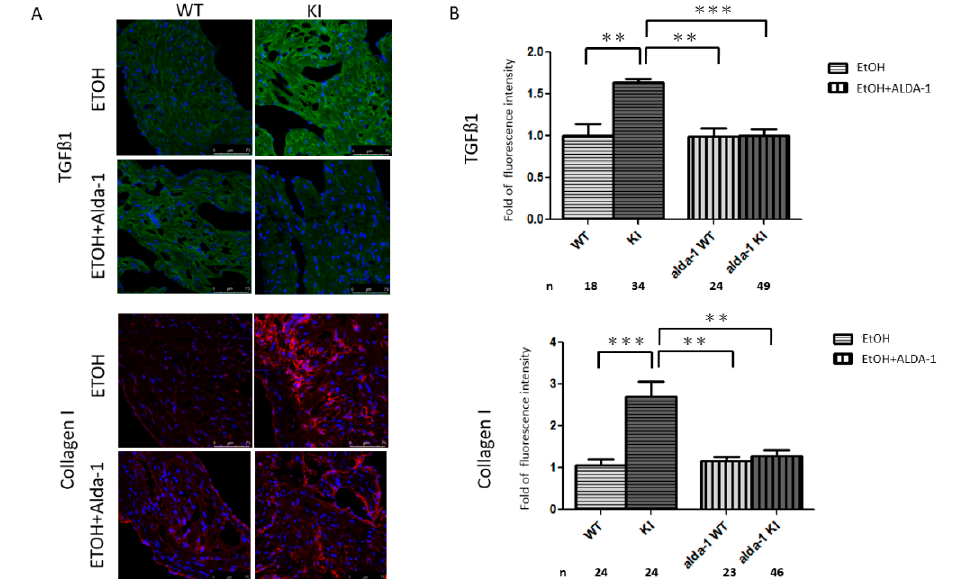
Figure 4. Atrial structural remodeling in wild-type and ALDH2*2 KI mice with chronic ethanol intoxication with and without Alda-1 treatment. ( A ) Representative confocal images showing the expression of transforming growth factor beta 1 (TGF- β 1) and collagen I in the atria of mice. ( B ) Relative intensities of TGF- β 1 and collagen I production were quantified. At least 10 random fields were chosen with scanning and averaging. Data are expressed as mean ± SE. n , the number of fields observed in each quantitative measurement; WT, wild-type; KI, heterozygous and homozygous ALDH2*2 KI mice; EtOH, ethanol, ** p < 0.01, *** p < 0.001.